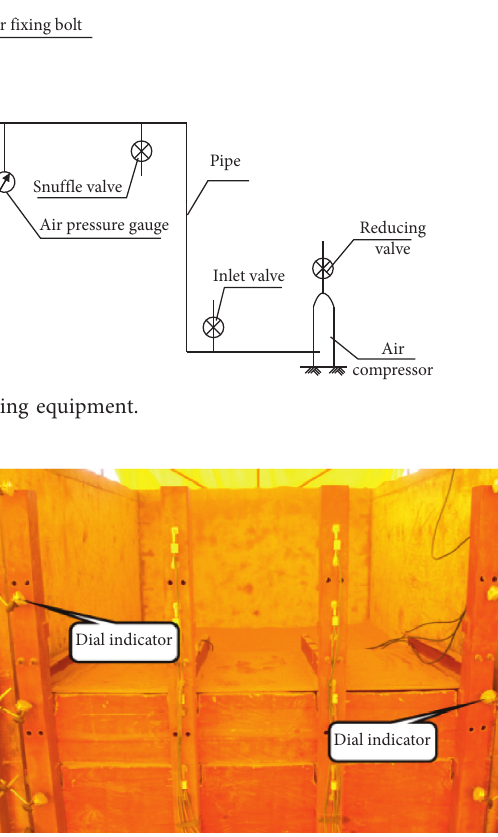
Figure 6: The real layout of the dial